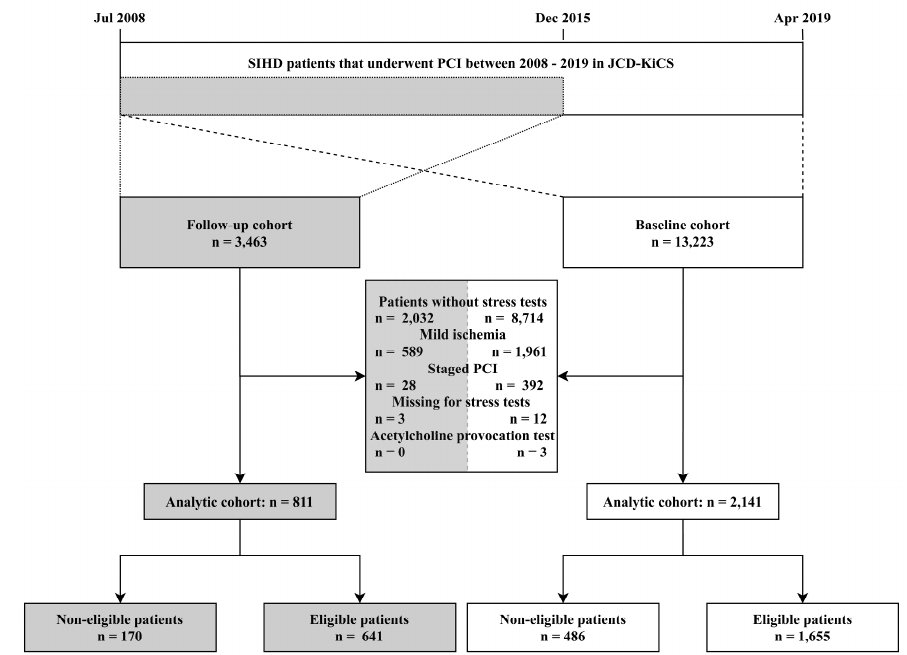
Figure 1. Study flow chart. Abbreviations: SIHD, stable ischemic heart disease; PCI, percutaneous Figure 1. Studyflowchart. Abbreviations: SIHD,stableischemicheartdisease; PCI,percutaneouscoronary coronary intervention; JCD–KiCS, The Japan Cardiovascular Database–Keio Interhospital intervention; JCD–KiCS, The Japan Cardiovascular Database–Keio Interhospital Cardiovascular Cardiovascular Studies.